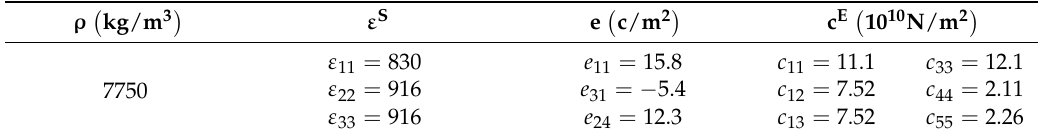
Table 3. The specific values of PZT-5A.